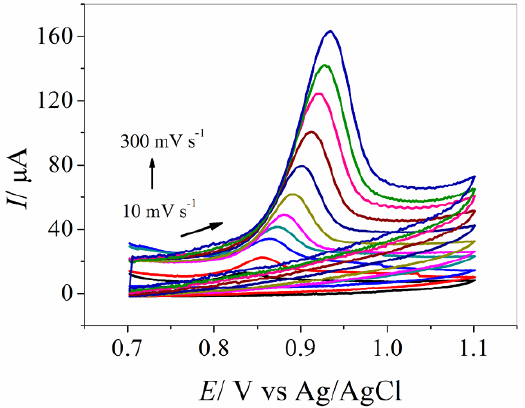
Figure 5. CVs of MWCNTs–DHP/GC electrode at various scan rates (v ) (from 10 to 300 mV s -1 ) in 0.1 mol L - 1 H presence of 5.0 × 10 -5 mol L -1 MTX and accumulation time of 300